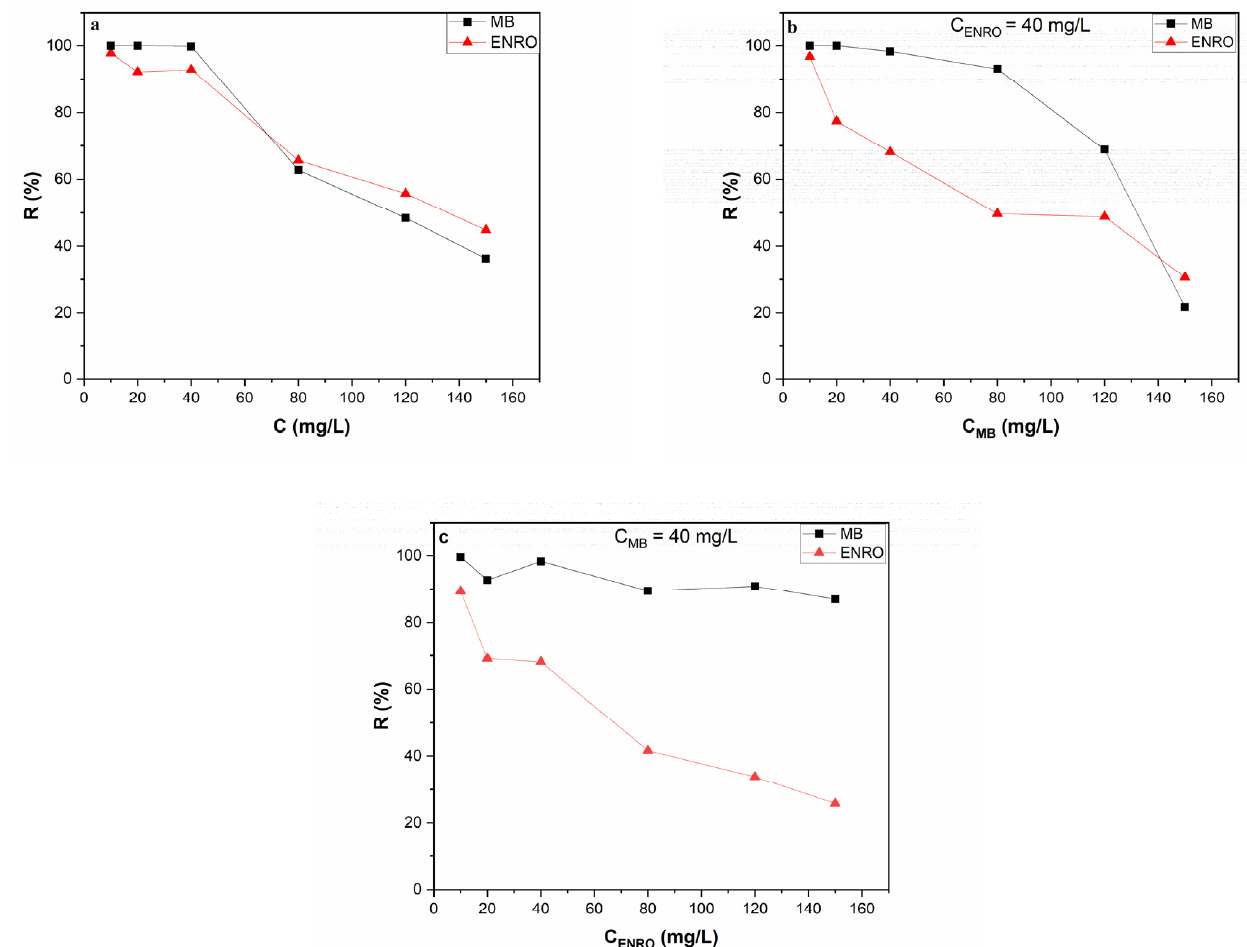
Figure 6. Effect of the initial concentration of MB and ENRO on the removal efficiency of the pollutants by HNC in single ( a ) and binary ( b , c ) systems. Conditions: ( a ) various concentrations of ENRO and MB, i.e., 10, 20, 40, 80, 120 and 150 mg/L ( b ) C ENRO = 40 mg/L and various concentrations of MB, i.e., 10, 20, 40, 80, 120 and 150 mg/L and ( c ) C MB = 40 mg/L and various concentrations of ENRO, i.e., 10, 20, 40, 80, 120 and 150 mg/L (pH = 6.2, C HNC = 2 g/L, T = 28 °C).